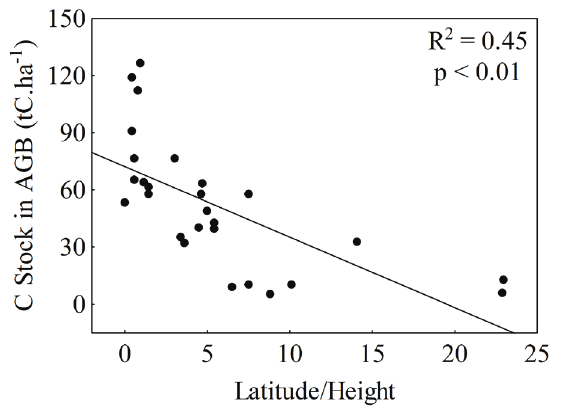
Figure 5 - Regression between carbon stock in the aboveground biomass (AGB) and the Latitude/Canopy Height ratio ( F = 20.0; p < 0.01; R² = 0.45; y = 72.20 -